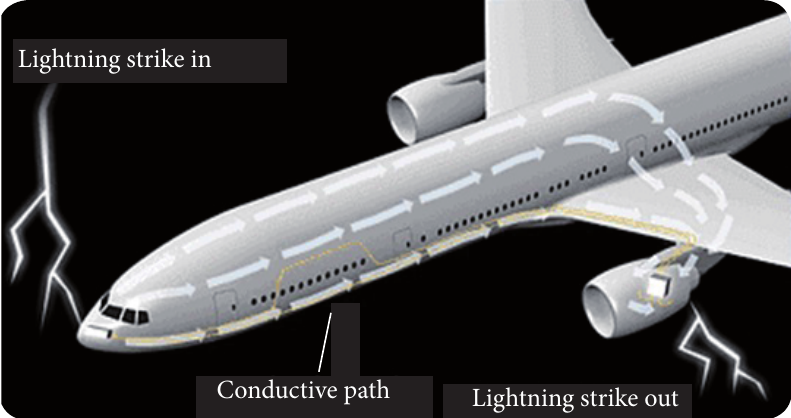
Figure 8. The continuous conductive path of low resistance over the entire aircraft exterior (Goraj